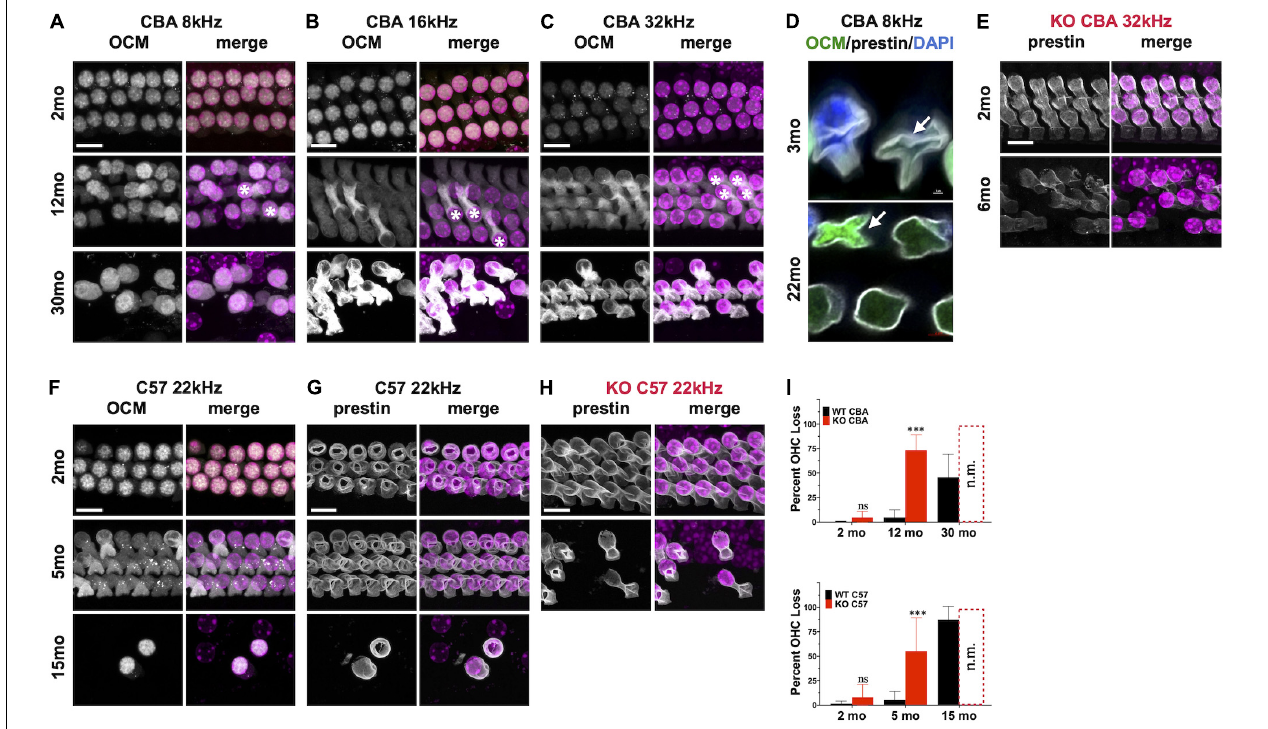
FIGURE 4 | Oncomodulin and Prestin are expressed in aged Outer hair cells (OHCs). (A–C) Surface preparations from 2 mo, 12 mo, and 30 mo CBA WT mice stained for OCM (gray) in the (A) 8 kHz, (B) 16 kHz, and (C) 32 kHz regions. Asterisk represents enhanced OCM immunoreactivity. (D) Upper panel: 3 mo-old CBA/CaJ WT OHC at 8 kHz. Arrow indicates collapsed OHC with low OCM expression. Lower panel: 22 mo-old CBA/CaJ at 8 kHz. Collapsed OHC with saturated OCM expression depicted by arrow. Stained with antibodies to OCM (green) and prestin (white) and co-stained with DAPI (blue). (E) 32 kHz region surface preparations from CBA KO mice stained for prestin at 2 mo and 6 mo. (F,G) 22 kHz region surface preparations from 2 mo, 5 mo, and 15 mo C57 WT mice stained for panles (F) OCM and (G) prestin. (H) 22 kHz region surface preparations for C57 KO mice stained for prestin at 2 mo and 5 mo. (I) Upper panel: CBA WT and KO OHC loss quantified from surface preparations. Lower panel: C57 WT and KO OHC loss quantified from surface preparations. OHC loss was not measured from the KOs at 30 mo and 15 mo (n.m.). Loss was averaged from samples taken along the entire cochlear spiral. Error bars are S.D. of 3 samplings. Asterisks represent significance ( p < 0.05) from aged-matched WT. n.s. is not